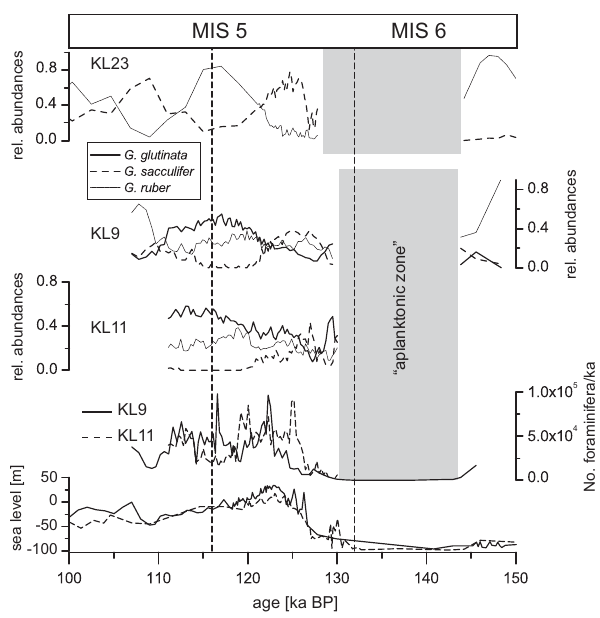
Fig. 3. Relative abundances of the dominant planktic foraminifera species in KL23 (Geiselhart, 1998; Schmelzer, 1998), KL9 and KL11 (data from this study); their absolute abundances in KL9 and KL11 and sea-level reconstructions from oxygen isotopes (Rohling et al., 2008b based on Siddall et al., 2004) for the investigated in- terval. Grey bars indicate “aplanktonic zone” (Fenton et al., 2000). Dashed vertical lines mark the MIS 5e/d (116ka BP) and MIS 6/5e boundary (132ka BP, Shackleton et al., 2003).